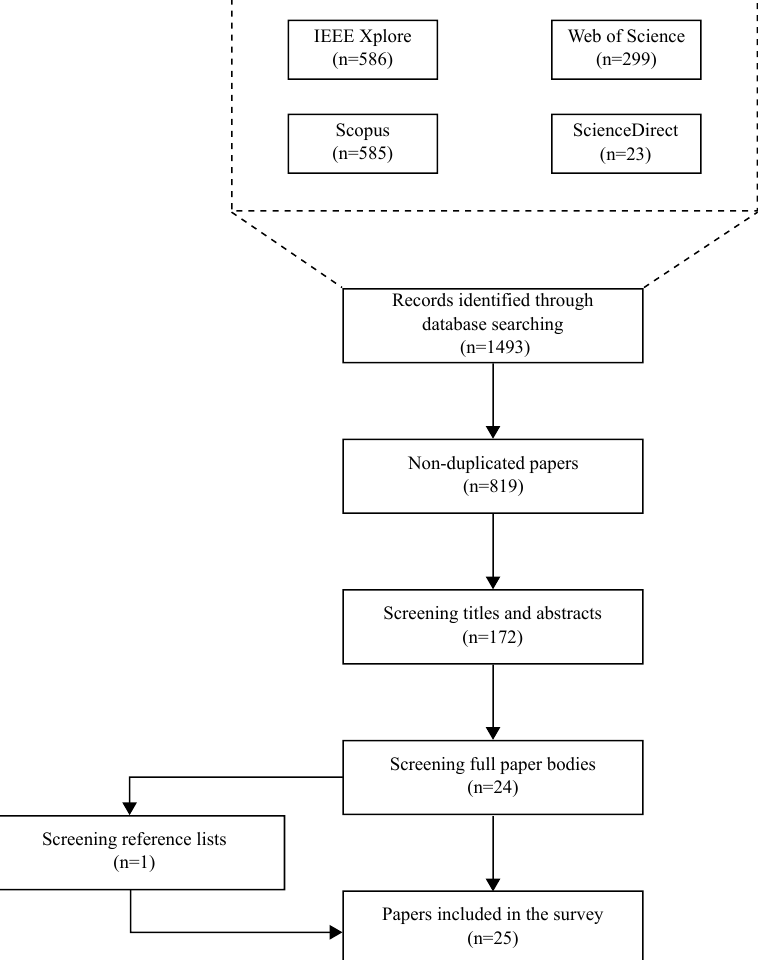
Figure 2. Systematic paper review process according to preferred reporting items for systematic reviews and meta-analyses (PRISMA) statement [5].